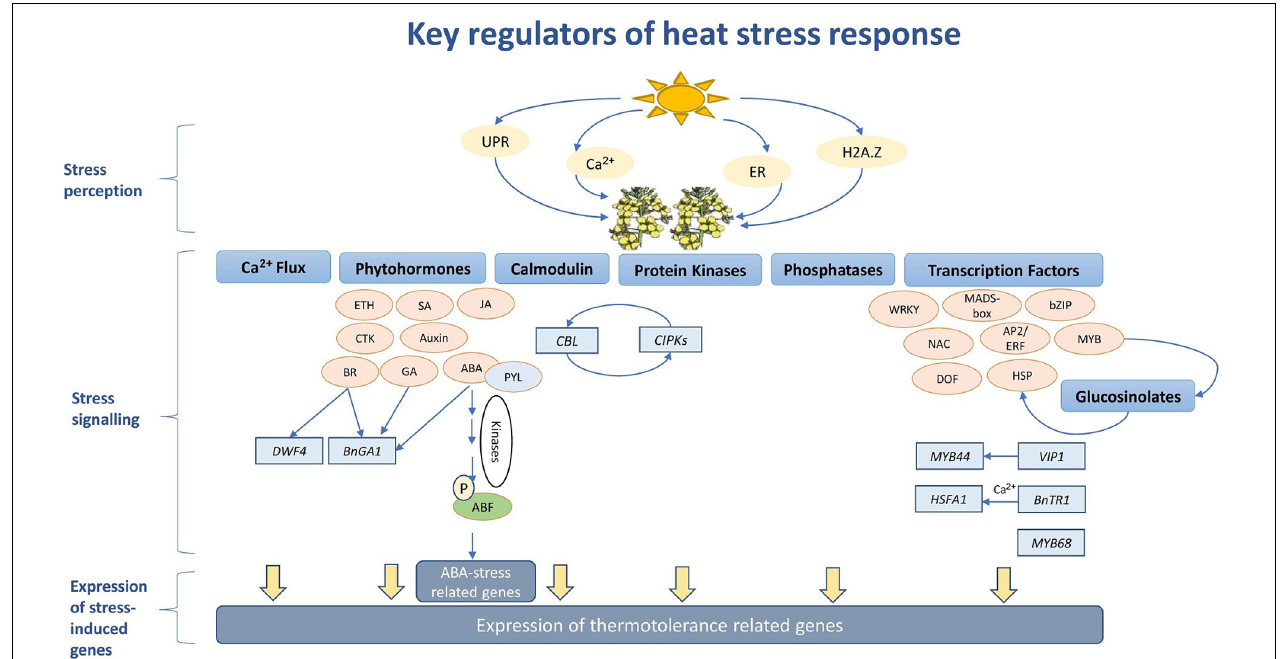
FIGURE 2 | Major flowering time regulators in Brassica